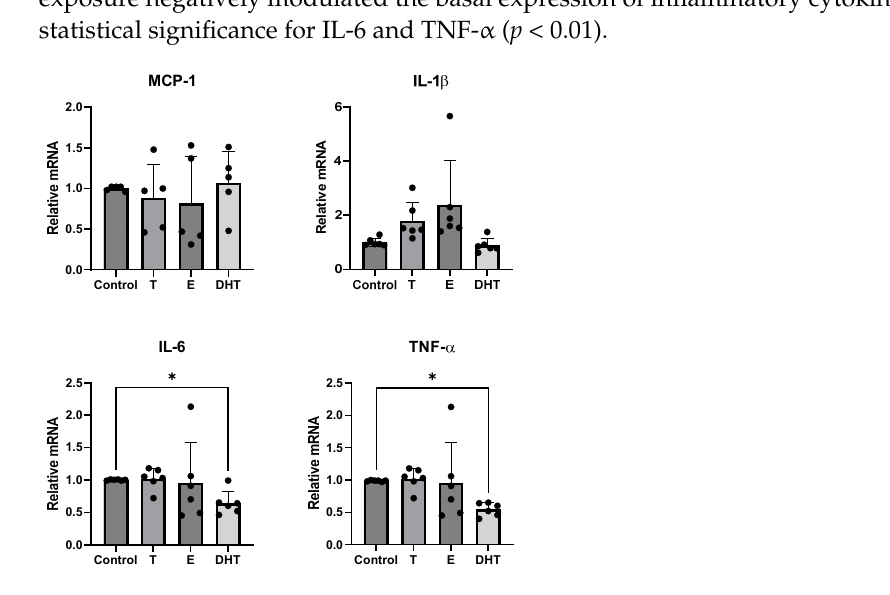
Figure 2. Restinggene expression of inflammatory cytokines (MCP-1, IL-1 β , IL-6, and TNF- α ) in human adipocytes in the presence of testosterone (T), 17 β -estradiol (E), and dihydrotestosterone (DHT). Control adipocyte cultures were incubated in the presence of vehicle only. A complete set of six experiments for each treatment was performed from each subject and run in triplicate. Data are expressed as mean ± SD. Each black dot represents the mean of triplicate measurements of a single experiment. * p < 0.05 with respect to control group.